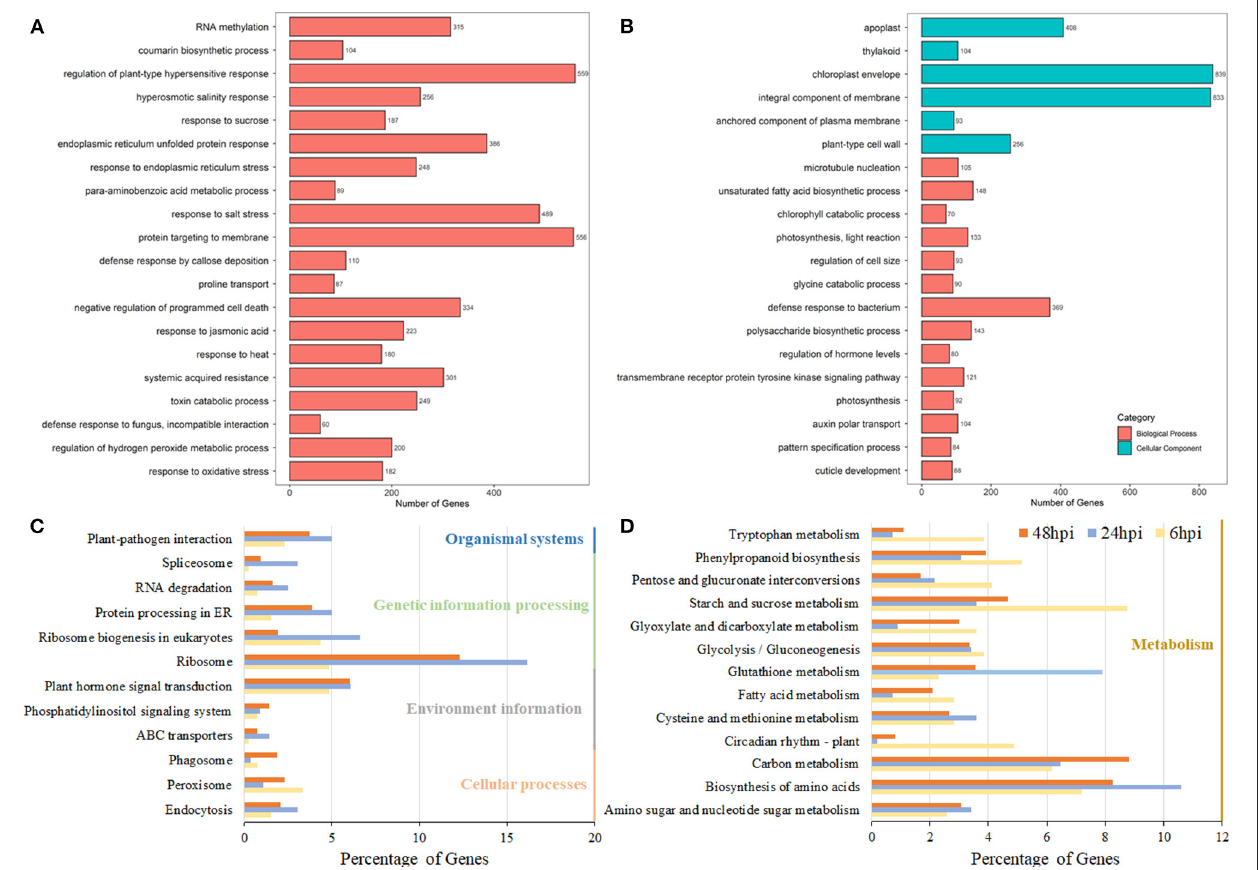
FIGURE 2 | Pathway analysis of DEGs in B. napus based on the gene ontology (GO) and Kyoto Encyclopedia of Genes and Genome (KEGG) databases. The GO enrichment analysis of Group 1 (A) and Group 2 (B) . The y-axis indicated the numbers of annotated genes, and the x-axis indicated the GO terms. The GO analysis was conducted using the Blast2Go software. (C,D) The KEGG enrichment analysis of DEGs at the 6-, 24-, and 48-hpi stages. The x-axis indicated the ratio of the enriched gene number to the total gene number at three stages, and the y-axis indicated different enriched terms.